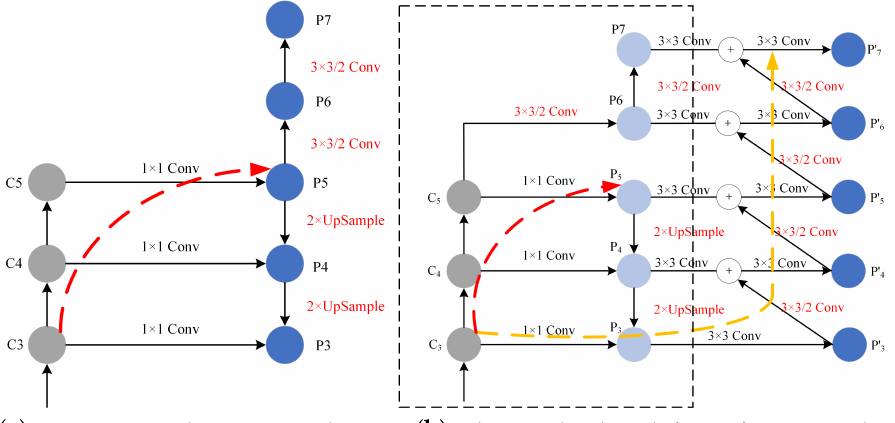
( a ) Feature pyramid structure in the Reti- ( b ) Bidirectional multi-scale feature fusion network. naNet network. Figure 2. The network structure of the feature fusion network. The red dotted line—the bottom-up path of the shallow information transmitted to the high level; the yellow dotted—the new bottom-up path; 1 × 1 Conv —convolution operation with the 1 × 1 convolution kernel; 2 × UpSample —the double upsampling operation by bilinear interpolation; 3 × 3/2 Conv —convolution operation with the 3 × 3 convolution kernel and a stride of 2, 3 × 3 Conv —convolution operation with the 3 × 3 convolution kernel and a stride of 1.